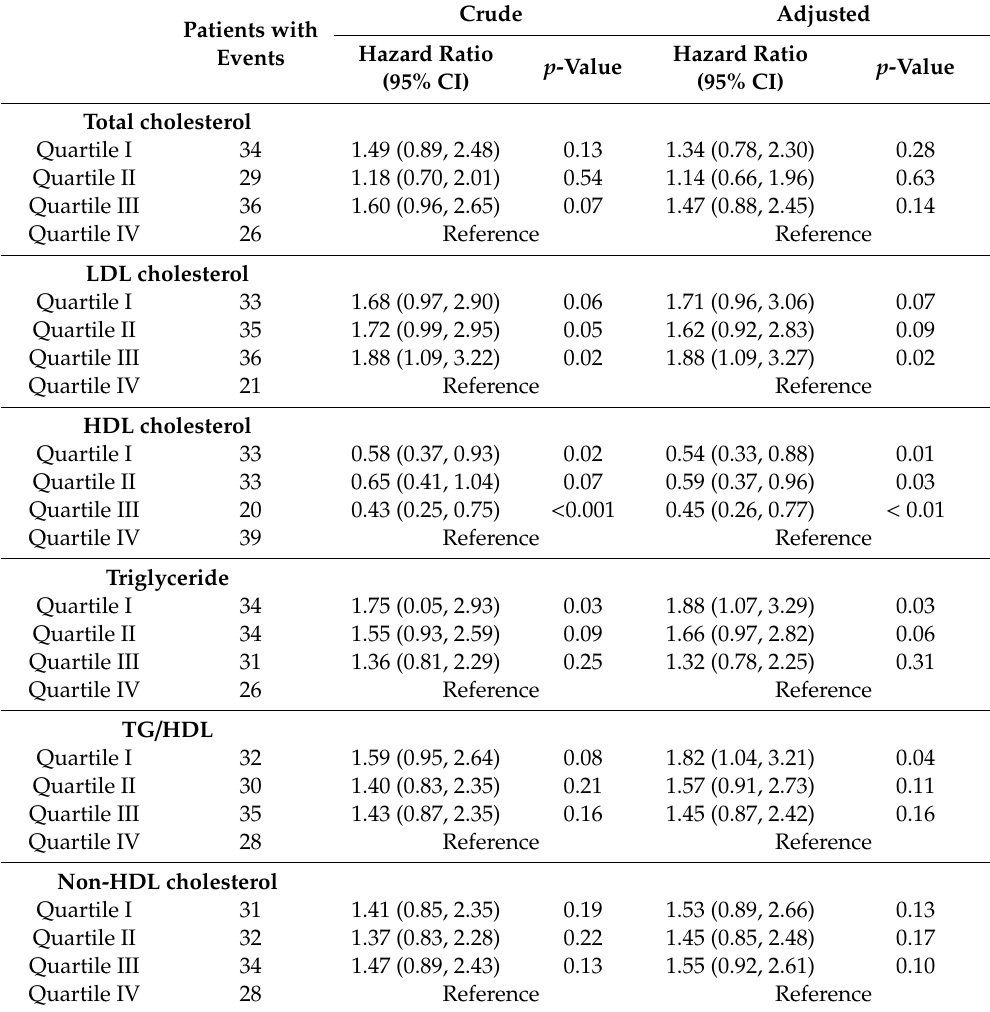
Table 2. Prognostic role of lipid profile with regard to disease